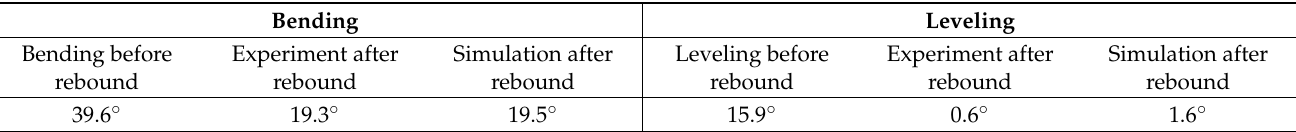
Table 6. Residual angles of bending-leveling by experiment and